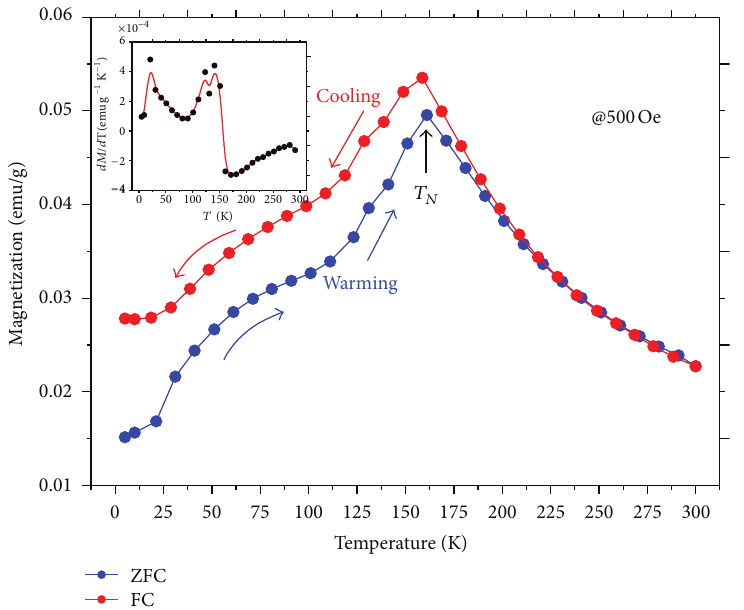
Figure 1: Temperature dependence of magnetization 𝑀(𝑇) under FC and ZFC processes measured at 500 Oe. Inset shows the temperature dependence of 𝑑𝑀/𝑑𝑇